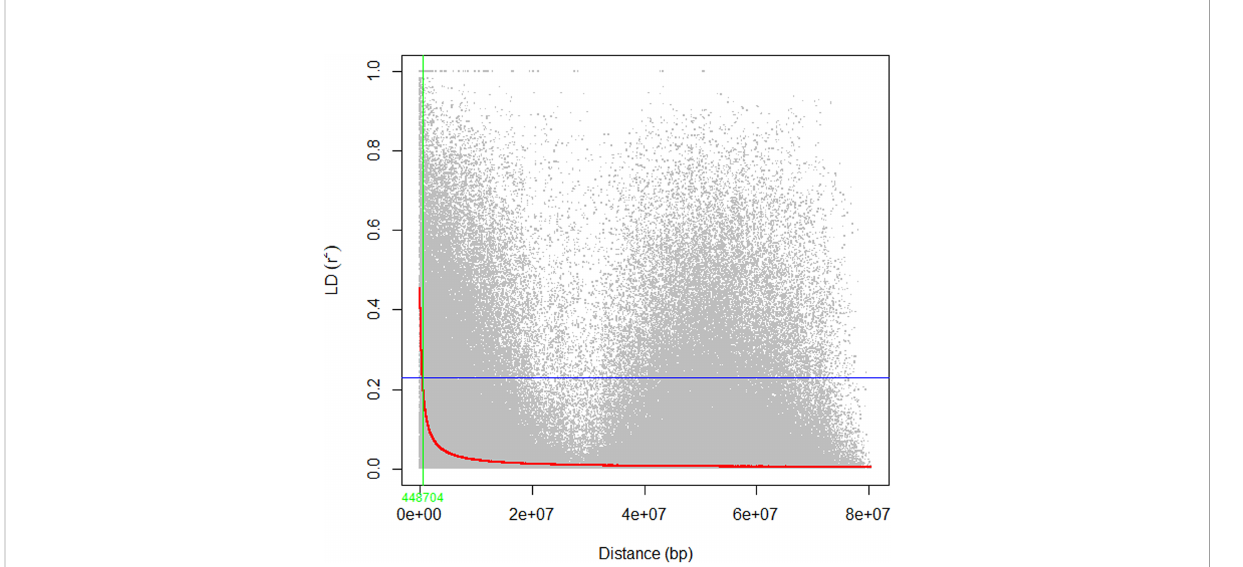
FIGURE 4 The scatter plot of genome-wide linkage disequilibrium (LD) decay determined based on the r 2 values of the marker pairs. The red curve line is the smoothing spline regression model fi tted to LD decay. The horizontal blue line is the half decay r 2 value of the genome (r 2 = 0.23), whereas the vertical green line is the genetic distance between markers in bp (448 kb) at the intersection between the half decay and the LD decay